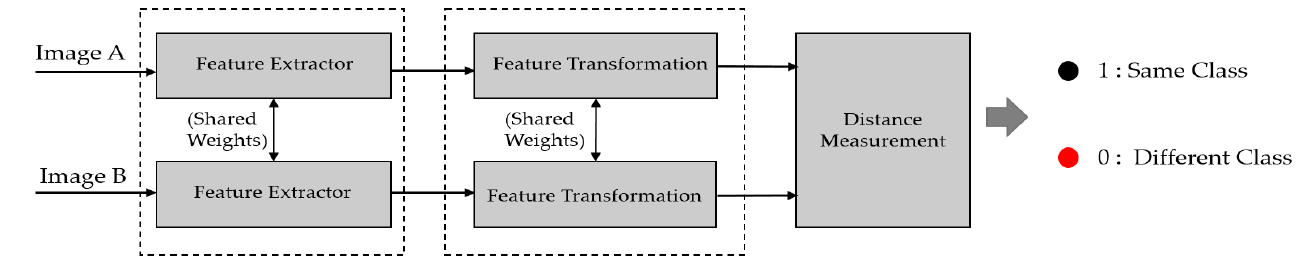
Figure 6. Design of our proposed FS network for measuring the distance between two input im- ages.